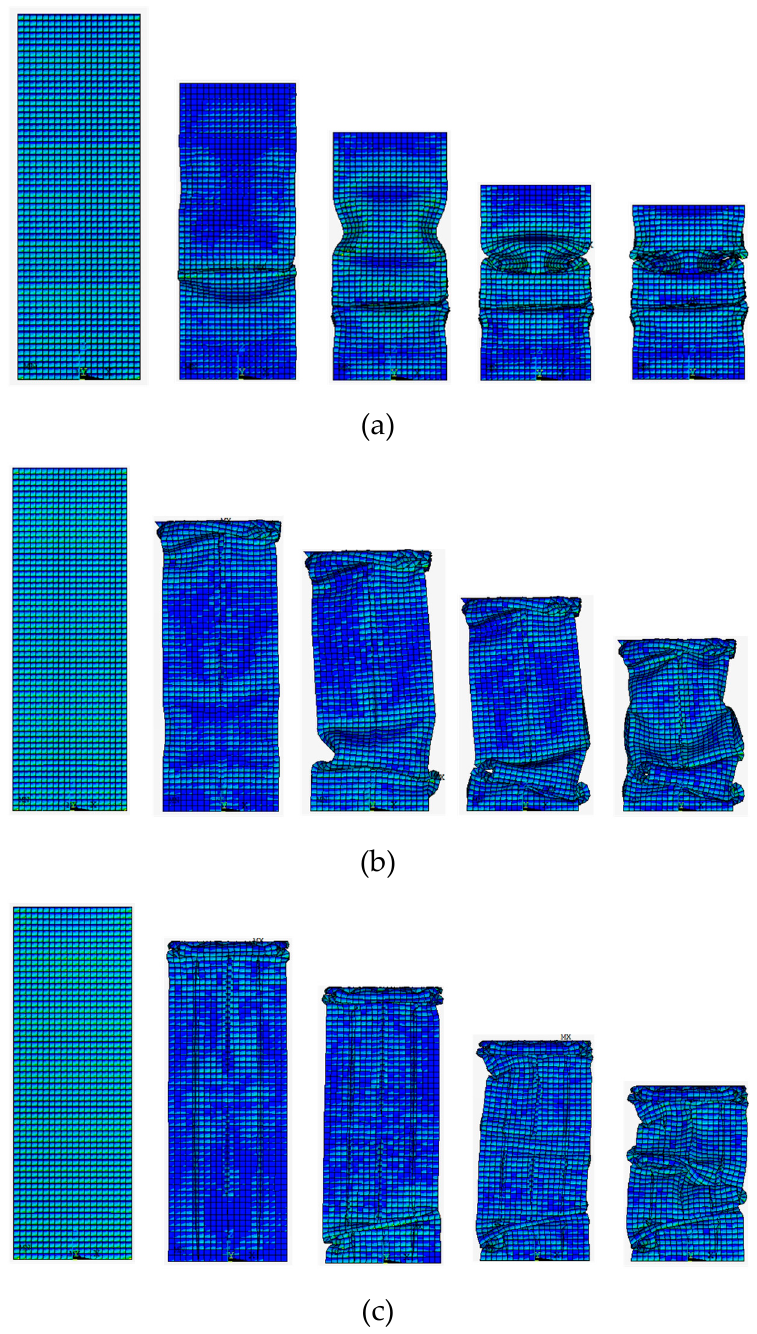
Figure 8. Deformation process of three FTTC columns: ( a ) 0th-order; ( b ) 1st-order; ( c ) 2nd-order.